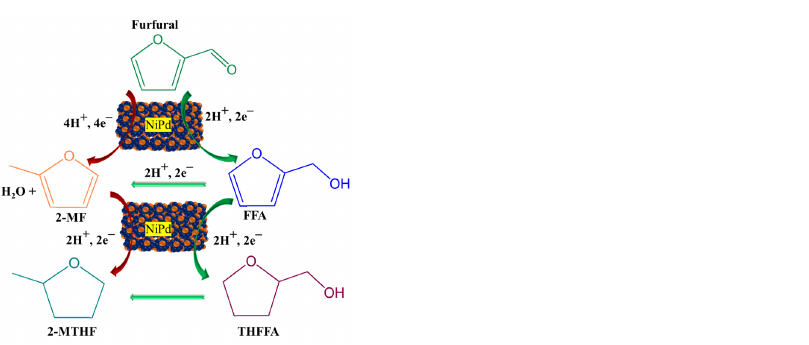
Figure 7. Possible electrocatalytic hydrogenation pathway of furfural (FF) over NiPd electrocatalysts.